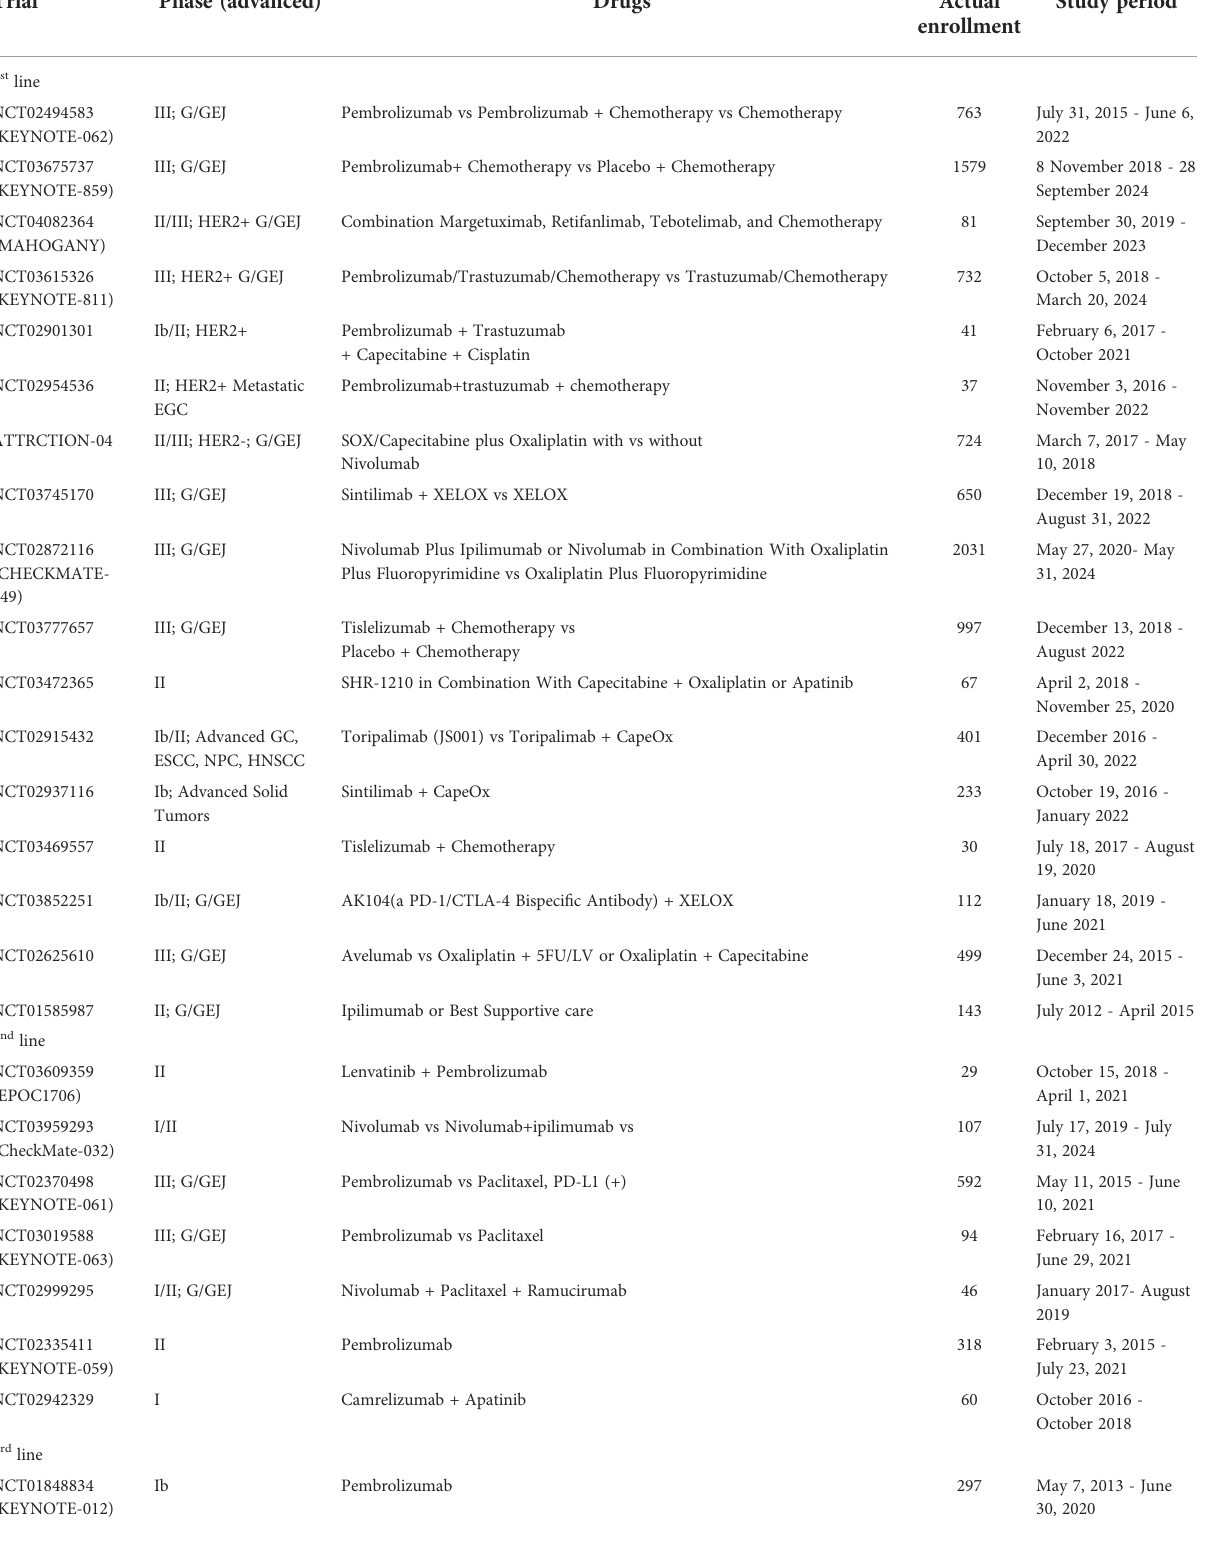
TABLE 1 Clinical trials of PD-L1/PD-1 inhibitors in GC. Trial Phase (advanced) Drugs Actual